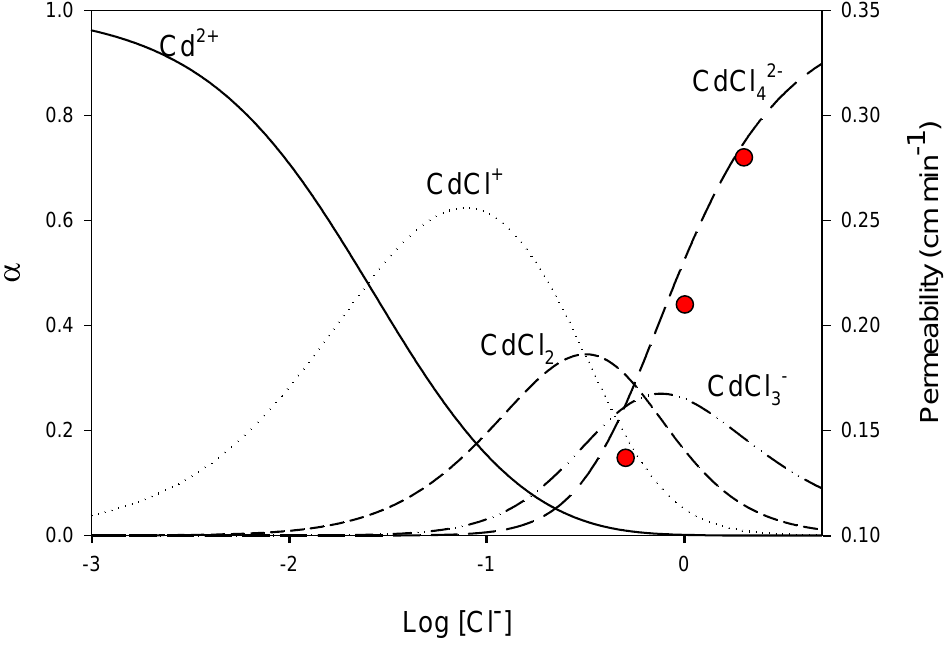
Figure 4. Variation of SLM permeability to Cd (closed circles) versus log [Cl − ] together with the speciation diagram of Cd (10 mg L − 1 ).